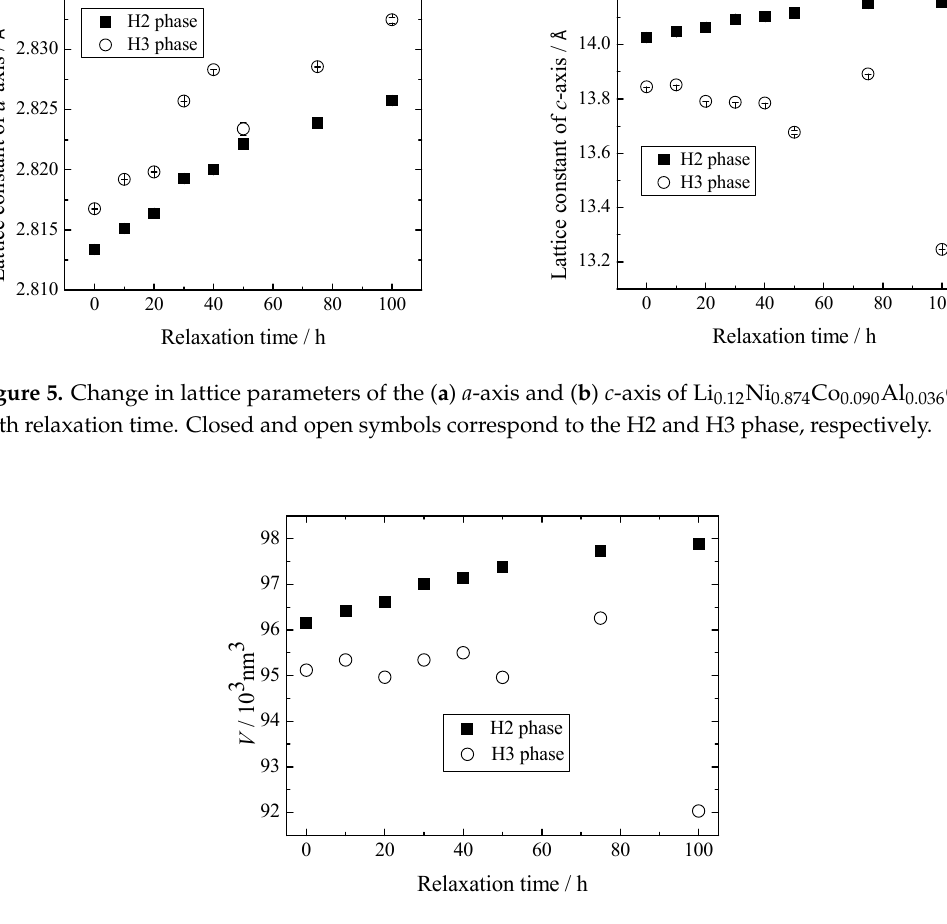
Figure 6. Changes in unit cell volume of Li 0.12 Ni 0.874 Co 0.090 Al 0.036 O 2 with relaxation time. Closed and open symbols indicate the H2 and H3 phase, respectively.